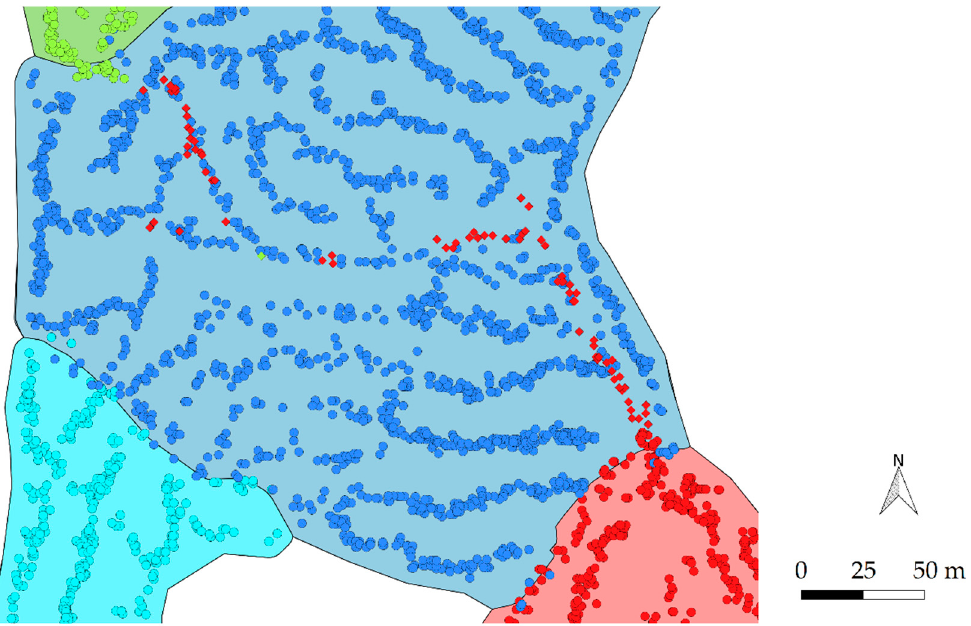
Figure A5. The trees of external strip roads (shown with diamond symbols) that locate within other stand, are transferred into that stand’s tree-wise removal data. The stand points and the polygons are colored to indicate different harvested objects. The ETRS-TM35FIN (EPSG:3067) coordinate system is used in the figure.